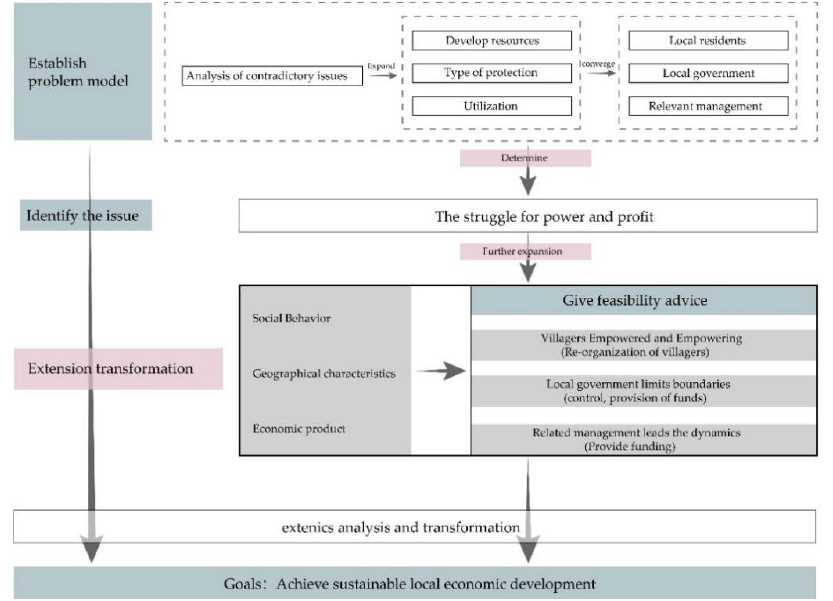
Figure 15. Path to solve power contradictions.